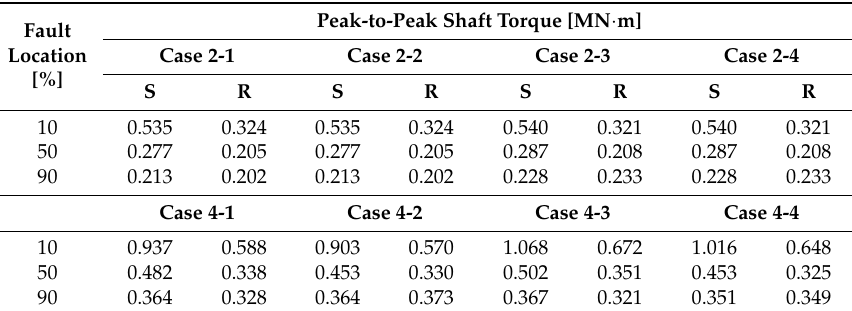
Table 3. Simulation result with respect to the single-phase fault.